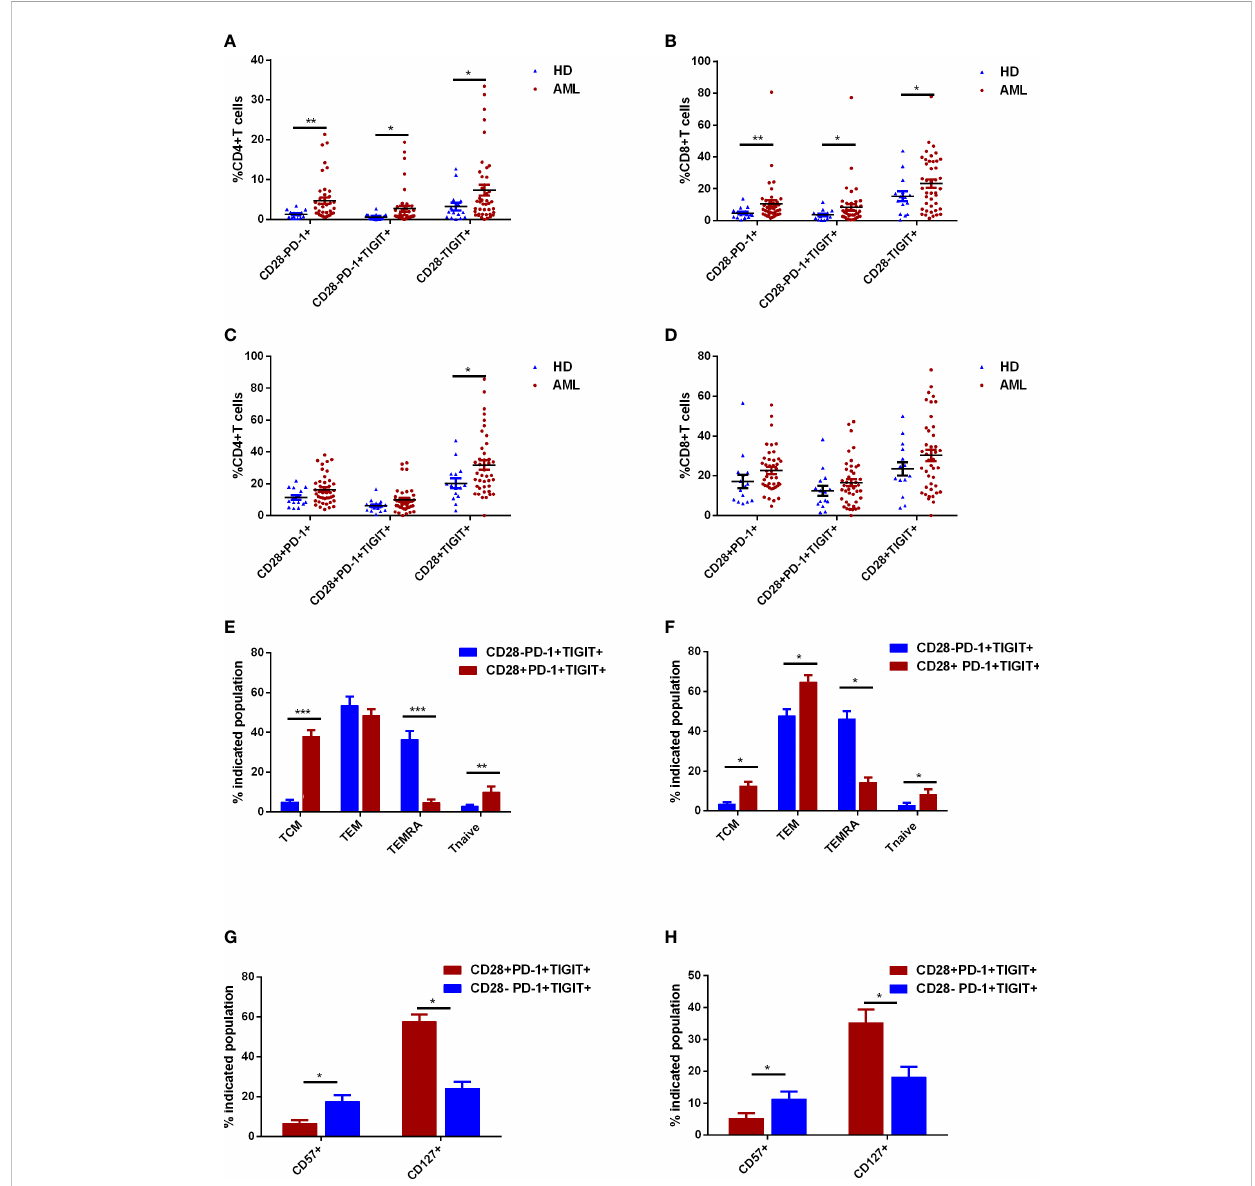
FIGURE 3 Further classi fi cation of exhausted T cells in the bone marrow (BM) of de novo AML patients using CD28 expression. The frequencies of CD28 - PD-1 + , CD28 - PD-1 + TIGIT + , and CD28 - TIGIT + subsets in CD4 + T cells (A) and CD8 + T cells (B) in BM were analyzed in de novo AML patients (n=42) and healthy donors (HDs, n=15). The frequencies of CD28 + PD-1 + , CD28 + PD-1 + TIGIT + , and CD28 + TIGIT + subsets in CD4 + T cells (C) and CD8 + T cells (D) in BM were further evaluated. Thereafter, the differentiated status of CD28 - PD-1 + TIGIT + and CD28 + PD-1 + TIGIT + subsets of CD4 + T cells (E) and CD8 + T cells (F) in BM were determined in AML patients. Moreover, CD127 and CD57 expression were also evaluated in CD28 - PD-1 + TIGIT + and its counterpart in CD4 + T cells (G) and CD8 + T cells (H) in BM of de novo AML patients. Student ’ s t test or Mann-Whitney U test was used to analyze the data according to normal distribution of data. *, ** and *** indicated p-values between 0.01 to 0.05, 0.001 to 0.01 and 0.0001 to 0.001,